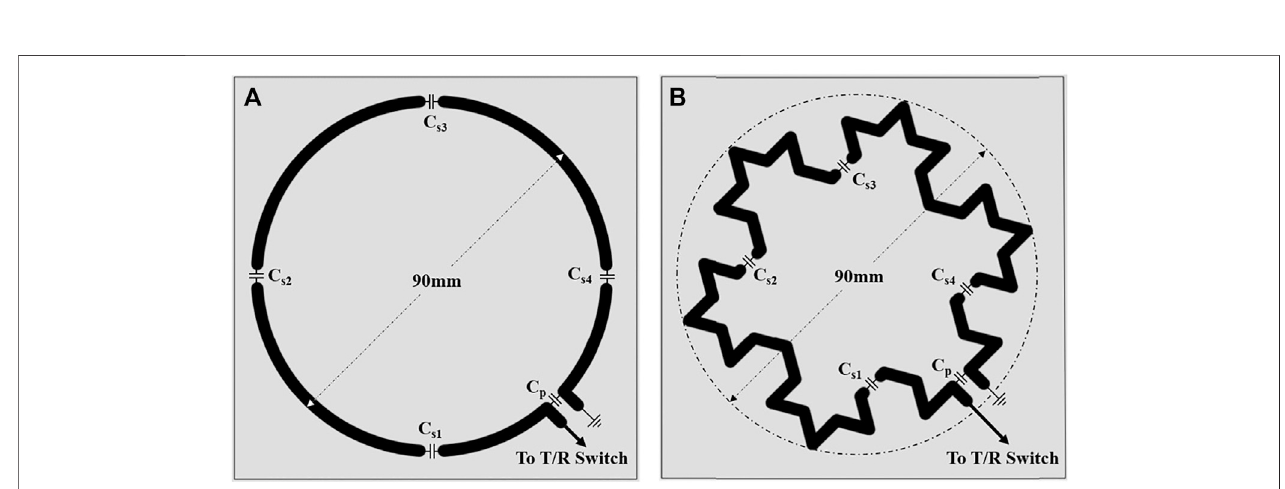
FIGURE 2 | The geometry of the (A) circular, and (B) fractal coil. Each were copper etched on a 100 × 100 mm FR4 substrate with breaks in loop for the tuning capacitors ( C s 1 − 4 ) and thematchingcapacitor( C p ).One end oftheloop forboth coilswasconnected totheT/R switch viaacoaxialcable while theotherend ofthe loop was grounded using the same coaxial cable to form a one port